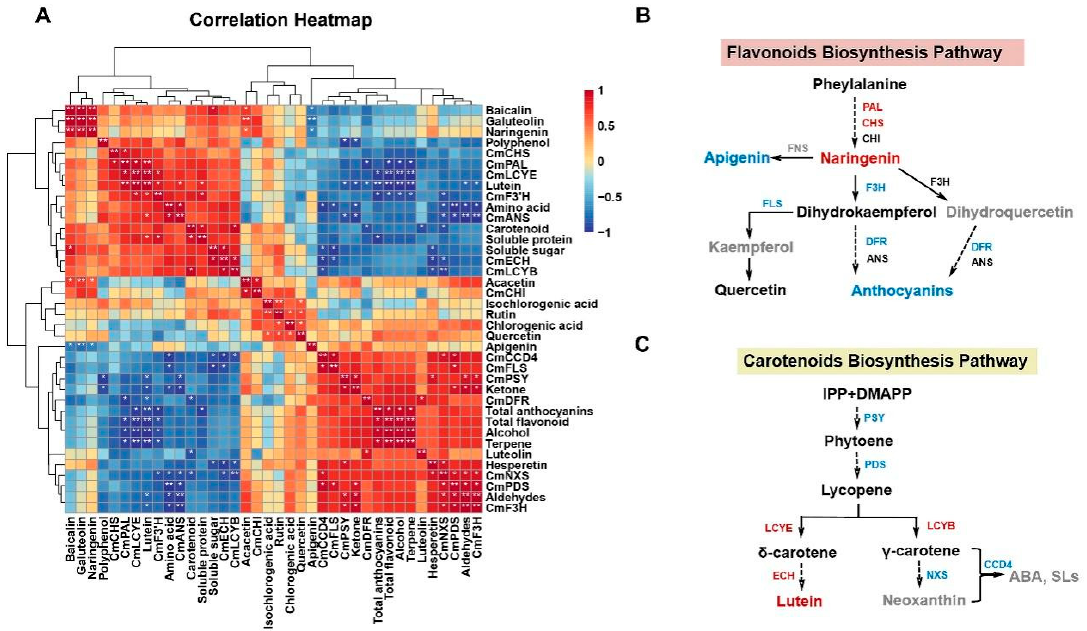
Figure 7. ( A ) The correlation analysis of detected metabolites and expression levels of related genes in PC and YM. ( B,C ) The working model of flower color transformation of YM. Red coloration means increased metabolites and gene expression in YM flowers compared to PC flowers, while blue coloration means decreased metabolites and gene expression in YM flowers. Gray coloration indicates the undetected metabolites in this study. Abbreviations: PAL, phenylalanine ammonia lyase; CHS, chalcone synthase; CHI, chalcone isomerase; FNS, flavone synthase; F3H, flavanone 3 ′ -